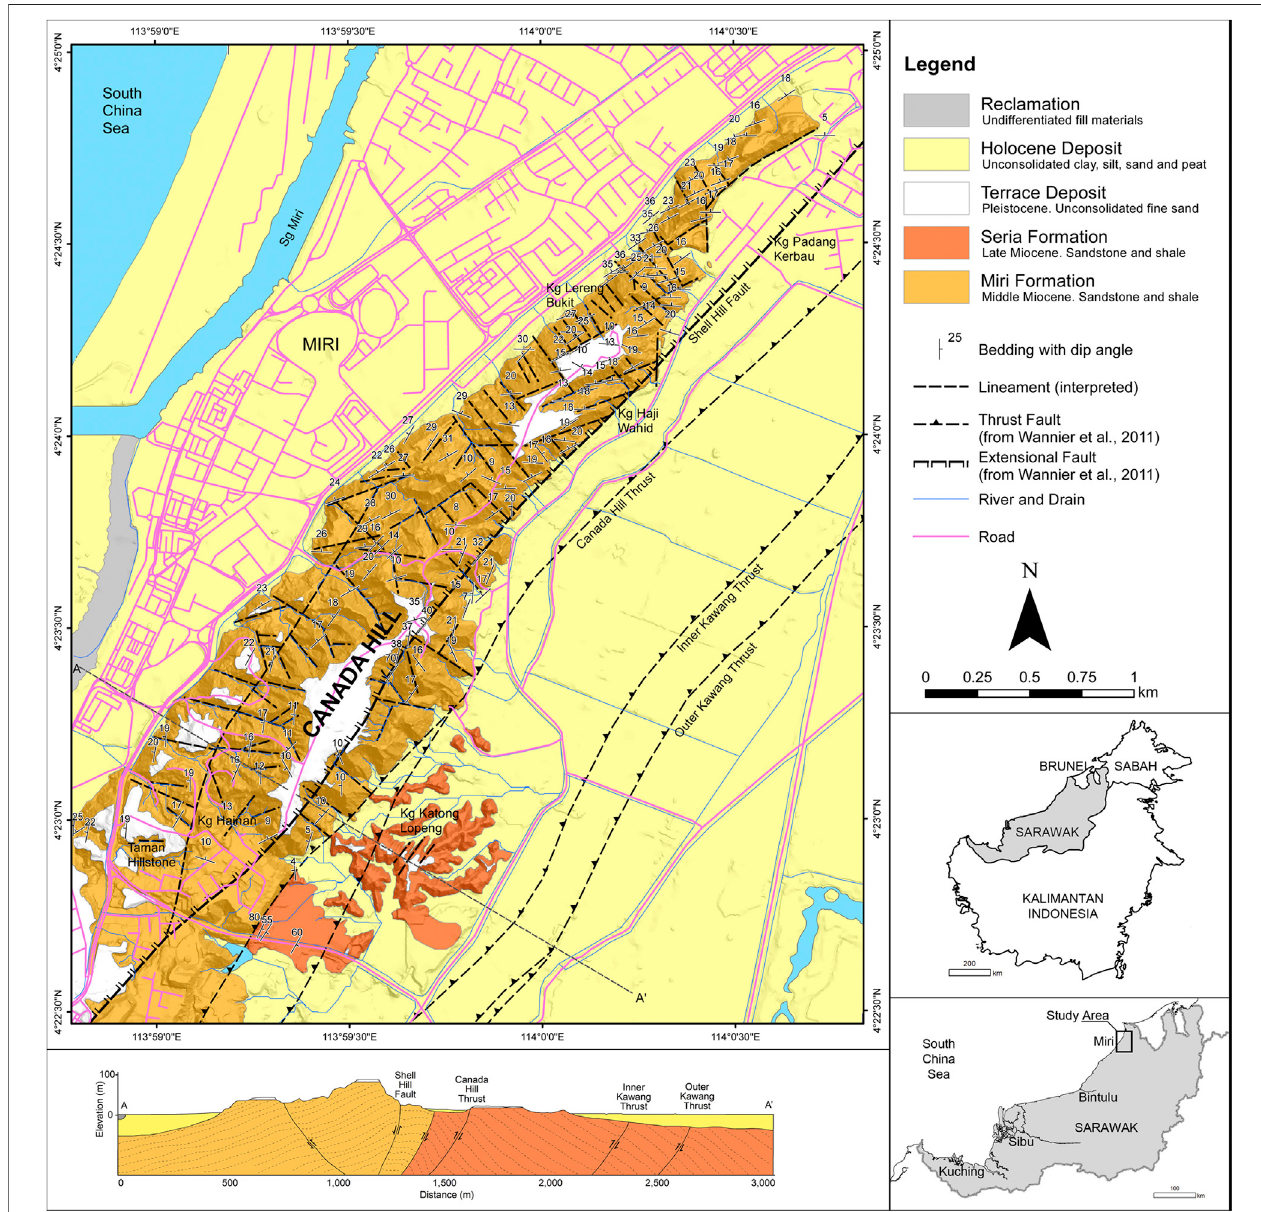
FIGURE 1 | Geological map and cross section of Canada Hill in Miri, Sarawak. Extension and thrust faults, and naming of Miocene geological units after Wannier et al. (2011).